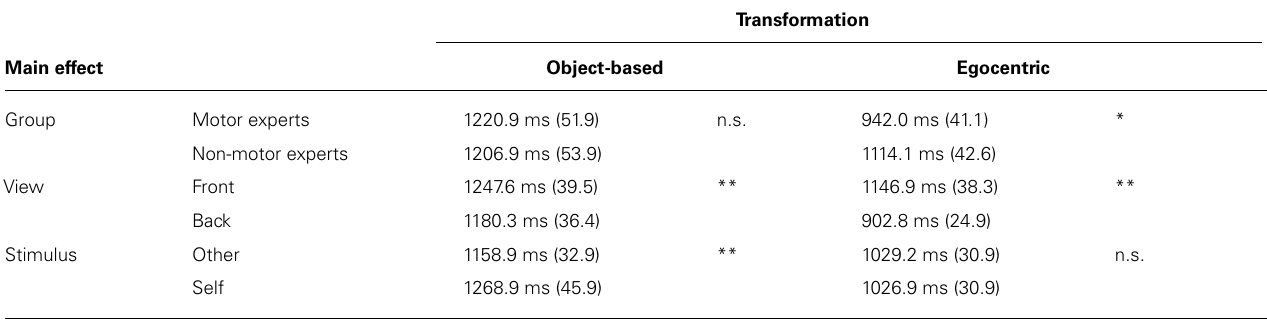
Table 1 | Main effects for the factors “group”, “view,” and “stimulus type” for object-based and egocentric transformations (mean RT and